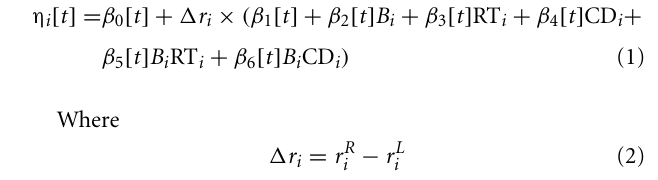
FIGURE 1 | spaceskip=0.2pc Structure of the task. Subjects were cued to respond after a 1 s delay from the appearance of the stimuli. In the “keep” version (K), subjects selected the preferred item and in the “discard” version